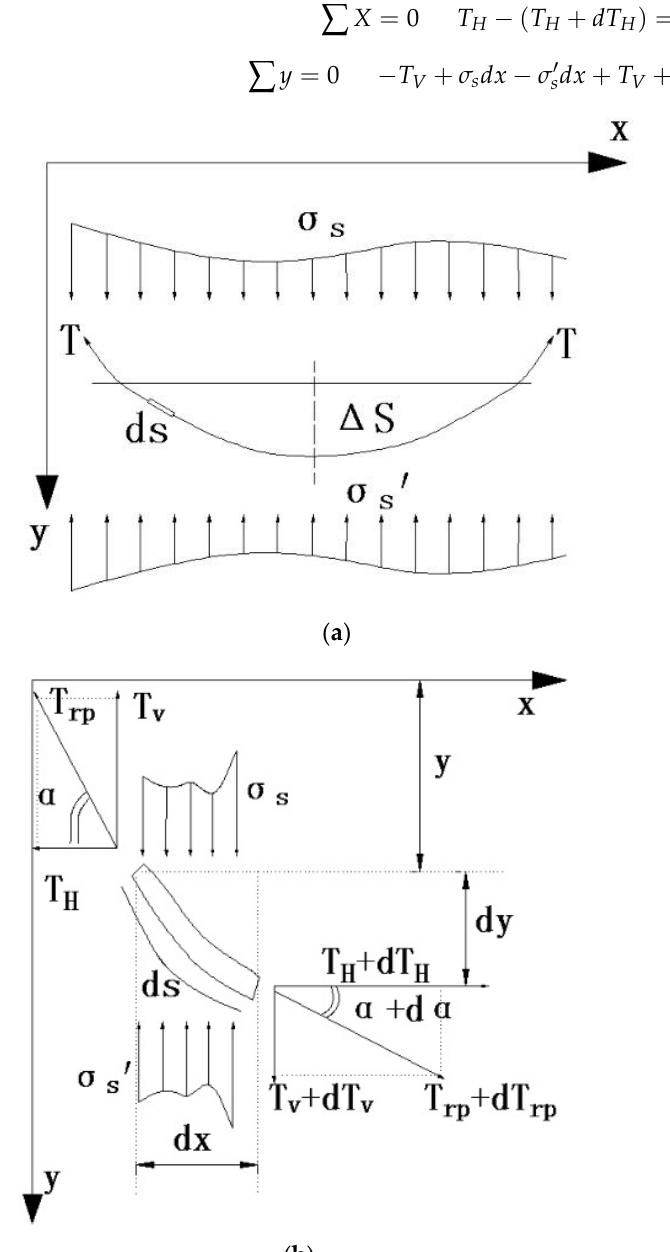
Figure 5. Mechanical analysis of GR: ( a ) force diagram of GR; ( b ) stress analysis of GR element. Solving Equations (20) and (21) leads